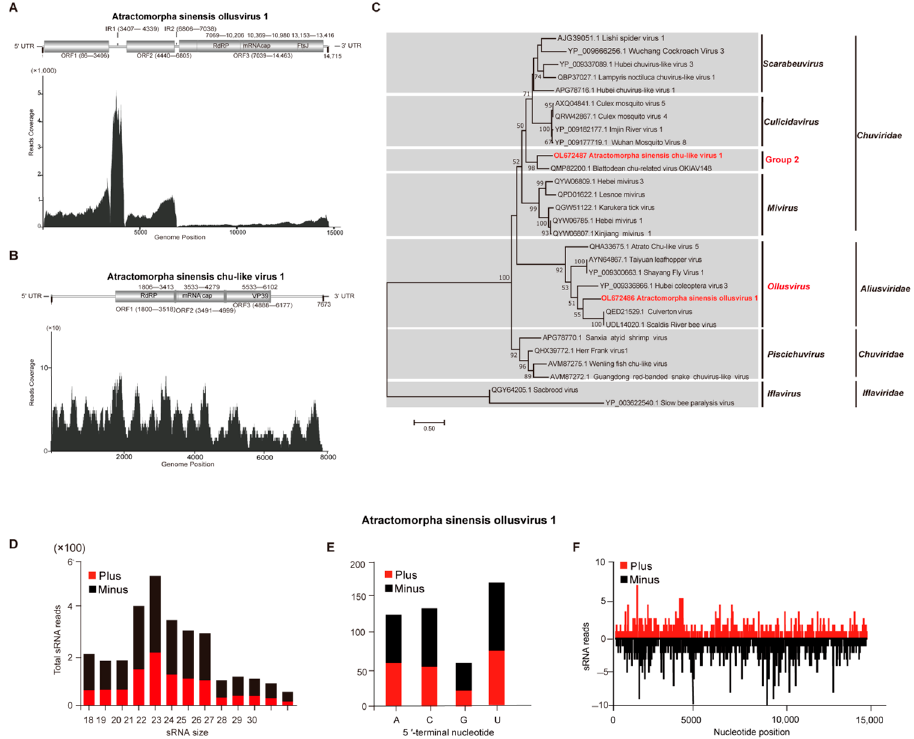
Figure 3. Atractomorpha sinensis ollusvirus 1 and Atractomorpha sinensis chu-like virus 1. ( A ) Ge- netic structure and transcriptome raw read coverage of Atractomorpha sinensis ollusvirus 1 (ASOV1); FtsJ, Ribosomal RNA methyltransferase; RdRP, RNA-dependent RNA polymerase do- main. ( B ) Genetic structure and transcriptome raw read coverage of Atractomorpha sinensis chu like virus 1 (ASCV1); VP39, Capsid Proteins, RNA-dependent RNA polymerase domain. ( C ) Phylo- genetic analysis of ASOV1 and ASCV1 and previously reported viruses in the Chuviridae, Aliusviri- dae, and Iflaviridae based on the conserved amino acid sequences. Bootstrap values are placed over each node of the tree (when > 50). Scale bars represent percentage divergence, and ASOV1 and